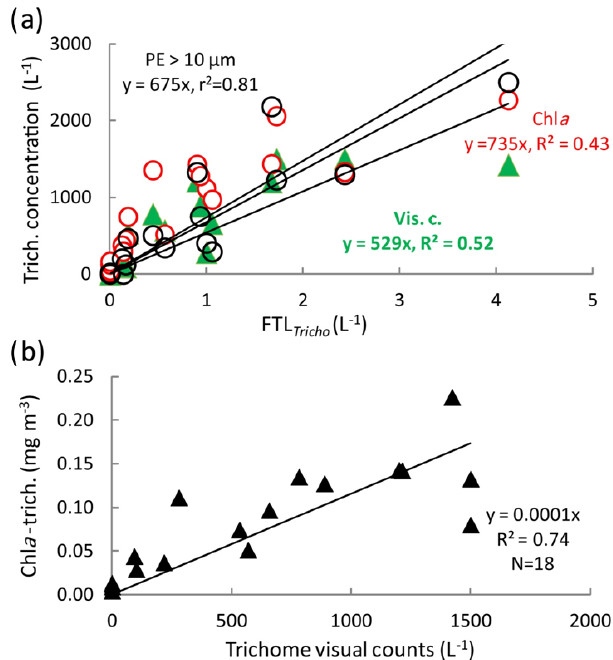
Figure 7. Correlations between the (a) trichome concentration esti- mated from PE > 10µm (in black) or Chl a (Trich.) (in red) or vi- sual counts (in green) and the FTL Tricho abundance (colony counts by UVP5 in L − 1 ), (b) Chl a (Trich.) versus trichome concentration from visual counts (trichomeL − 1